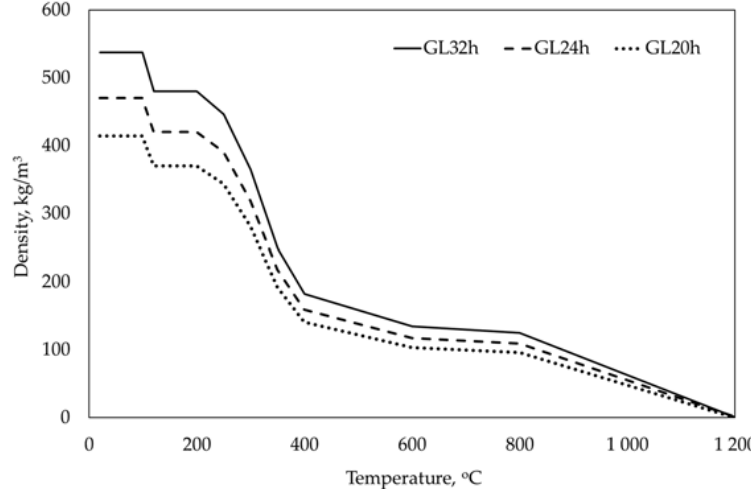
Figure 7. Density of wood.